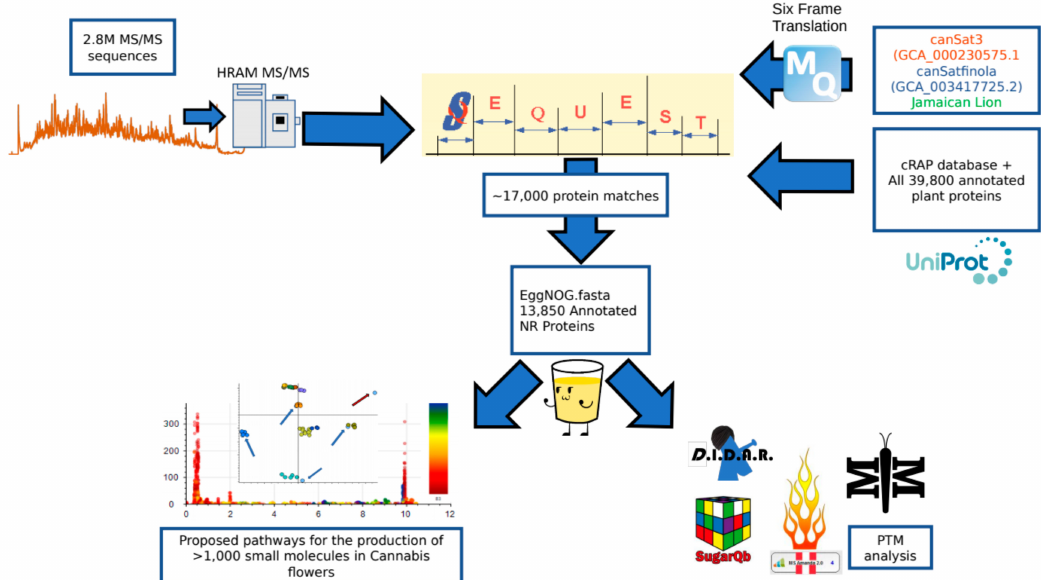
Figure 5. Peptide and protein identification pipeline. Two point eight million spectra obtained on a high resolution mass spectrometer were searched against a search space consisting of a six frame translation of three reference genomes as well as the cRAP FASTA and a complete collection of all green plant proteins hosted by UniProt. The 17,000 SEQUEST identifications were then processed with the eggNOG mapper program to annotate the identifications according to sequence orthology of the Viridiplantae database. This subsequent fasta could then be utilized to search the raw data for post-translational modifications using a variety of tools and identify pathways correlating to the small molecule profile of the